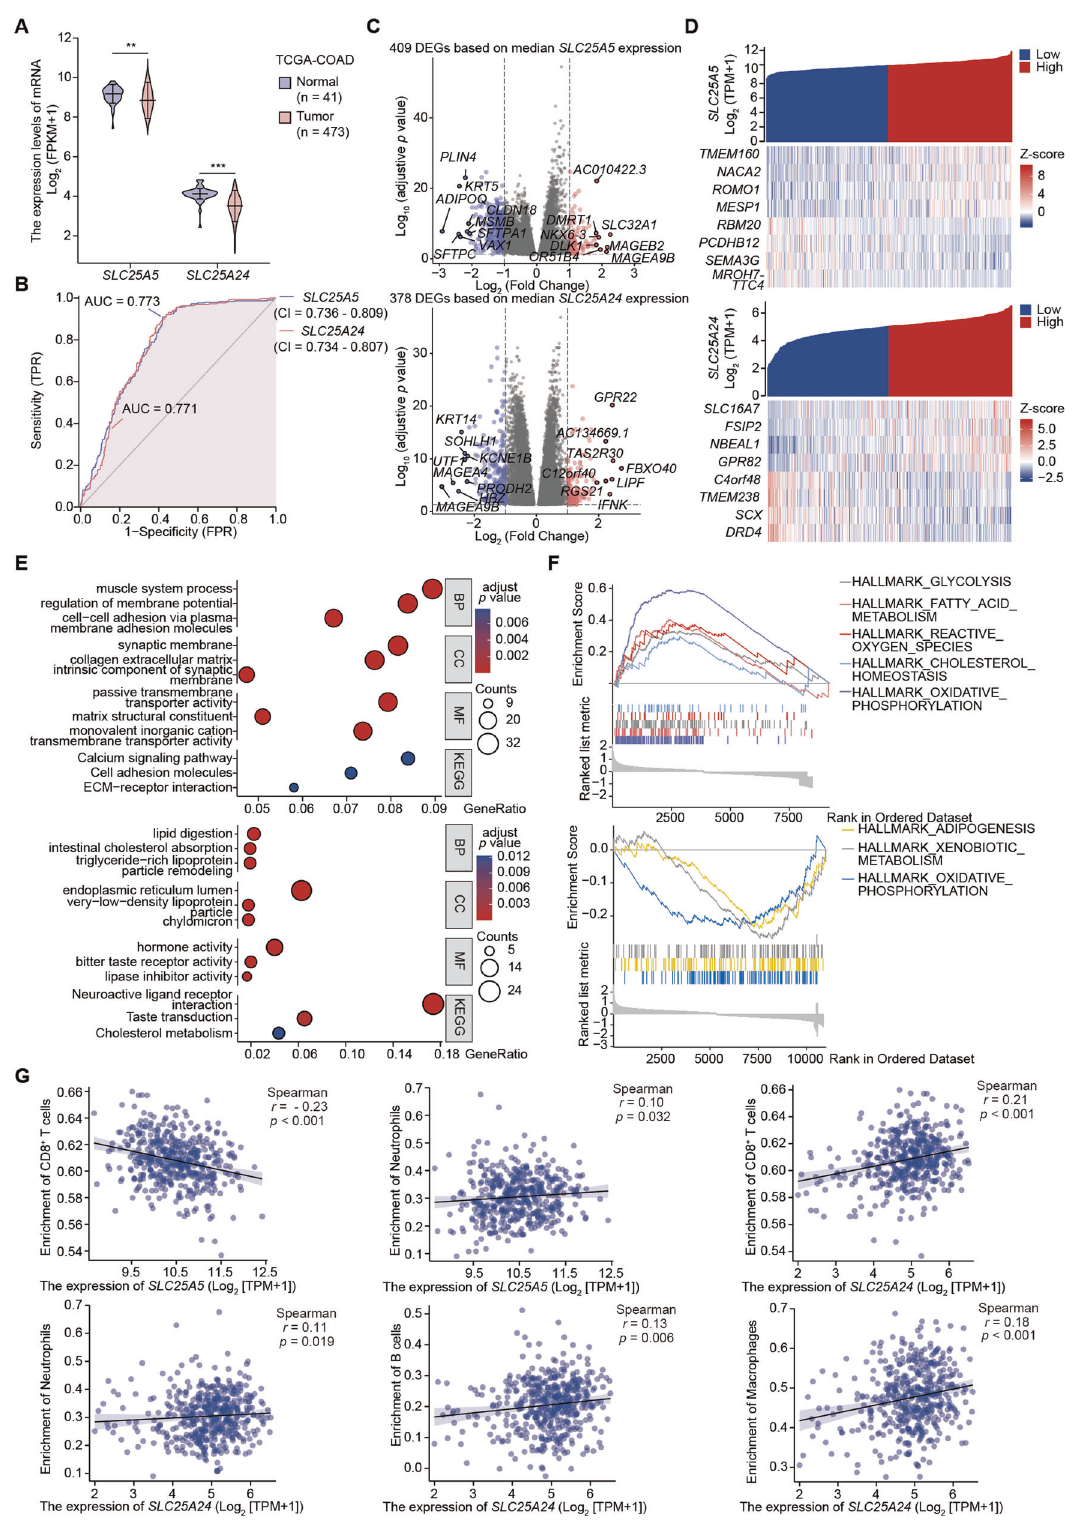
the activator of MAPK signaling pathway inhibited cell apoptosis (Fig. 8E, F) and promoted cell proliferation (Fig. 8G), suggesting the rescue of the SLC25A5 effect. The protein levels of p-MEK1/2 and p-Erk1/2 similarly increased in the presence of PDBu (Fig. 8H). These results indicated that SLC25A5 repressed tumorigenesis via the MAPK signaling